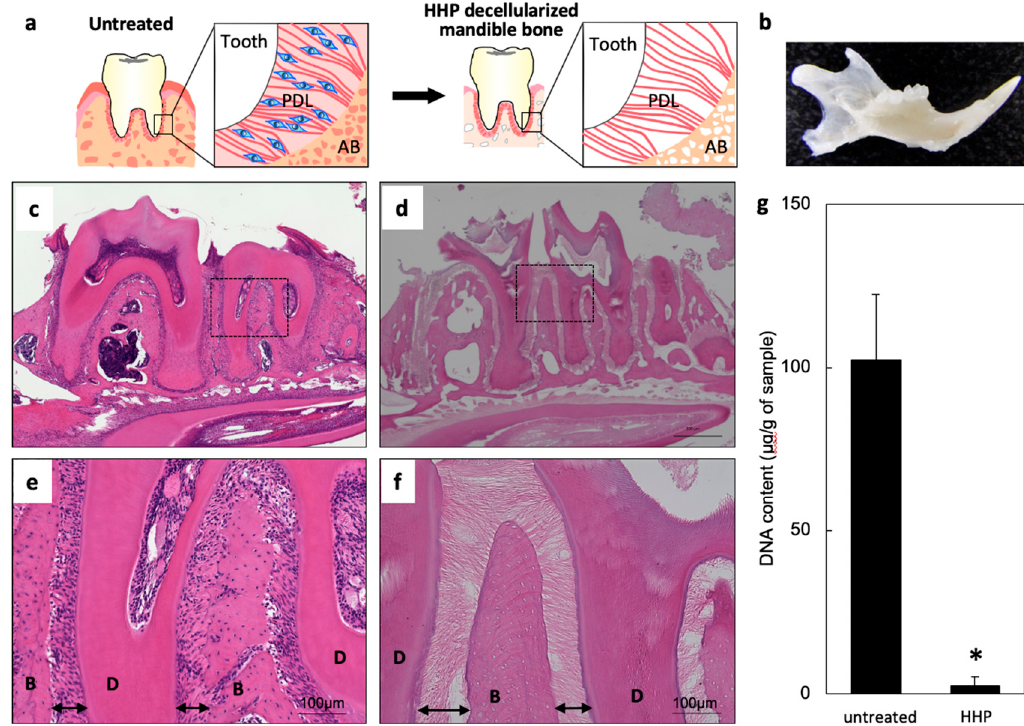
Figure 1. High hydrostatic pressure (HHP) decellularization of rat mandible bone. ( a ) Schematic illustration of the decellularization process. ( b ) Image of decellularized mandible bone. ( c – f ) Hematoxylin and eosin (HE)-stained sections of untreated ( c , e ) and HHP-decellularized ( d , f ) mandible bone. Arrows indicate the periodontal ligament (PDL) matrix area. B, alveolar bone; D, dentin. ( g ) Quantitative analysis of residual DNA ( n = 4). * p <